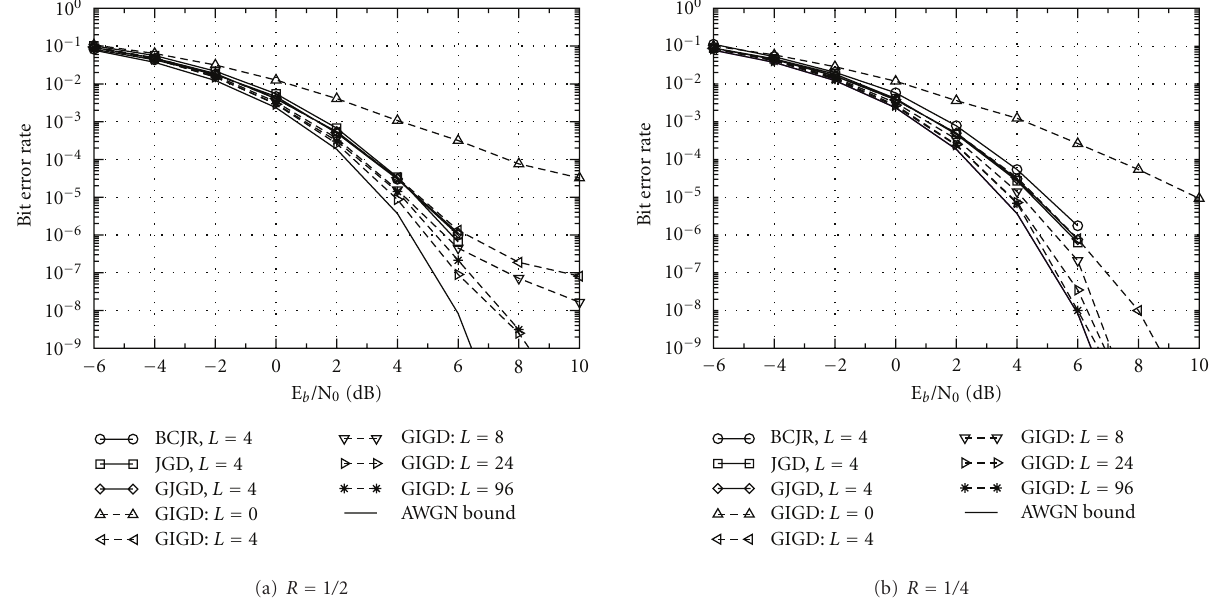
Figure 10: Performance comparison in repetition encoded systems, N T = N R = 4, K = 400, 5